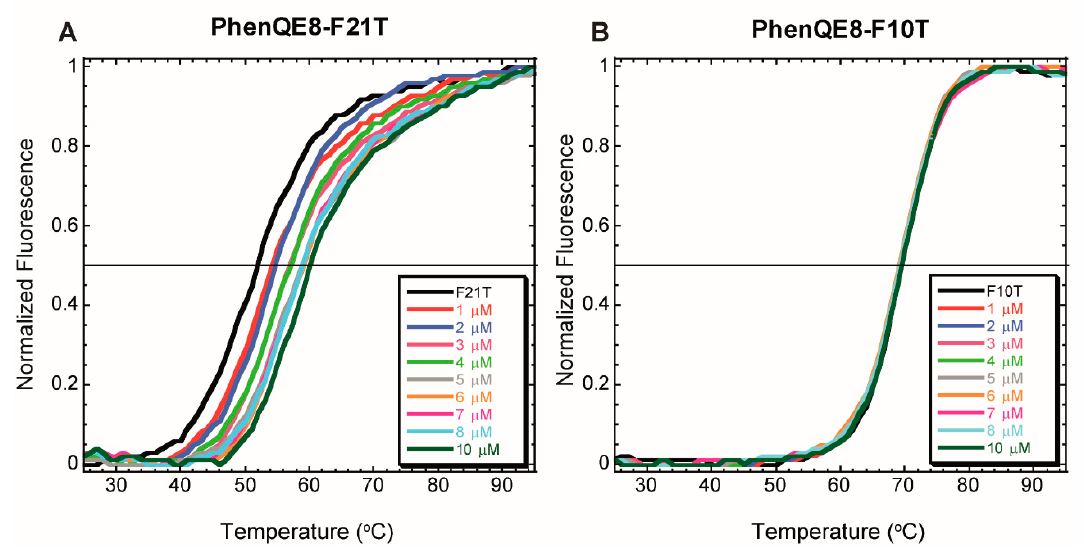
Figure 3. DNA FRET melting experiments for PhenQE8 at a concentration range between 1–10 μ M, in the buffer system 10 mM lithium cacodylate, 90 mM LiCl, 10 mM KCl with ( A ) telomeric oligonucleotide F21T; ( B ) duplex DNA F10T.